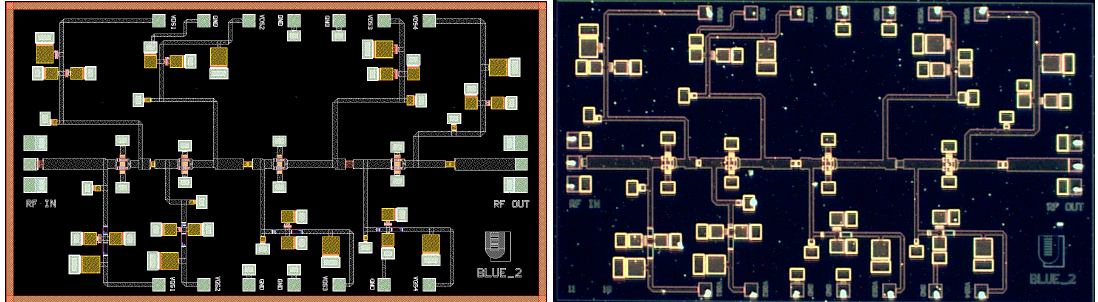
Figure 7. Layout and microphotograph of the designed LNA MMIC. Size is 3.6 × 2 mm 2